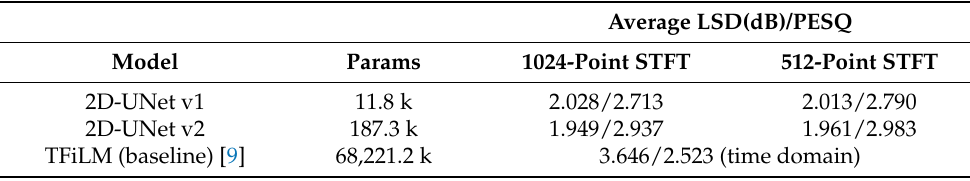
Table 1. Performance comparison for different STFT parameters.